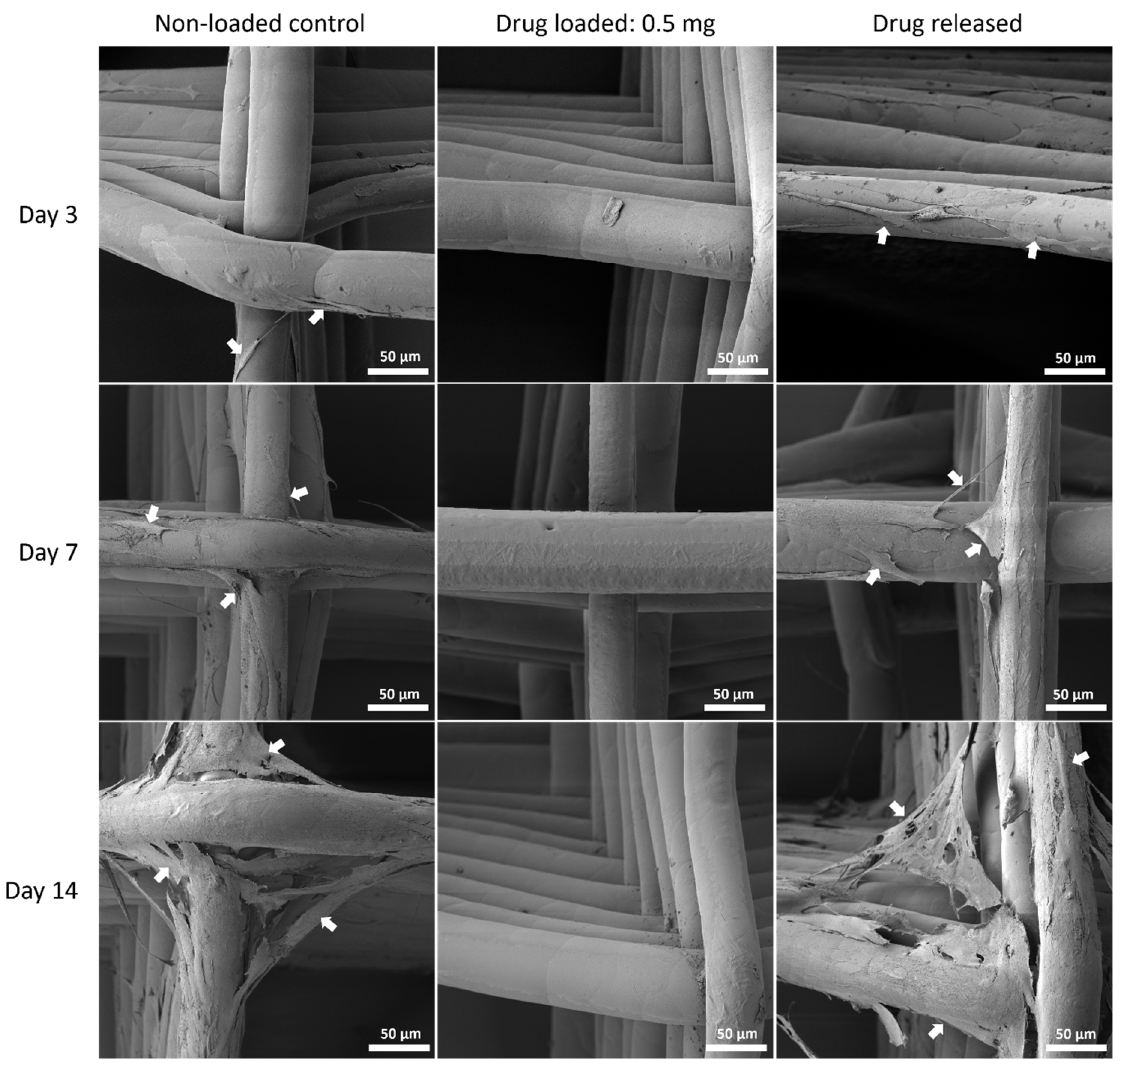
Figure 10. MSC cell morphology by SEM on PCL mesh groups at all time points. Arrows pointing at representative cells or cell sheets attached on mesh fibres.